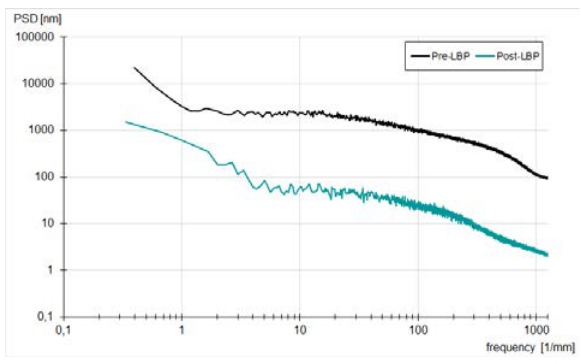
Fig. 7. Power spectral density functions for BK7 after preheating and postheating.